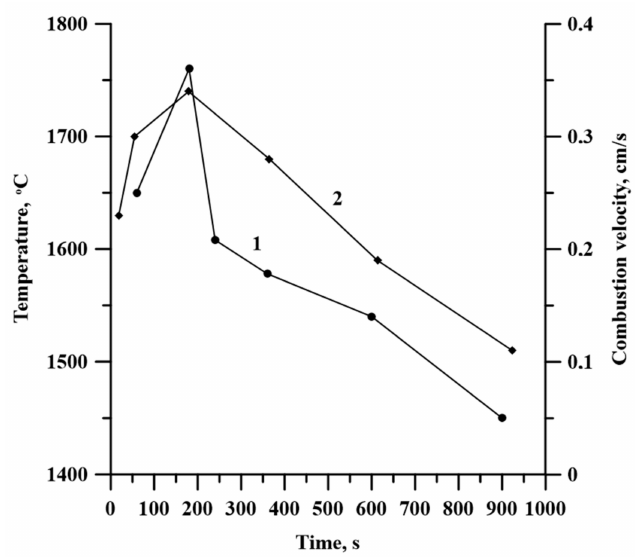
Figure 8. Time curves of combustion temperature (1) and velocity